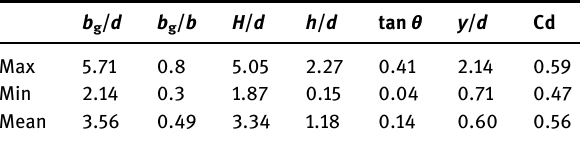
Table 1: The adequate dataset for the coe ffi cient of discharge for trapezoidal weir and rectangular gate